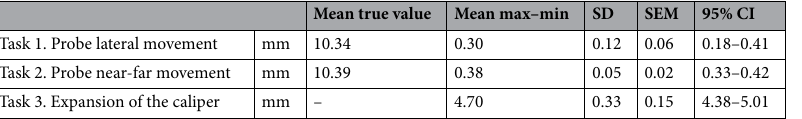
Table 2. Results of the reliability examination, repeated five times. max maximal, min minimal, SD standard deviation, SEM standard error of the mean, CI confidence interval.